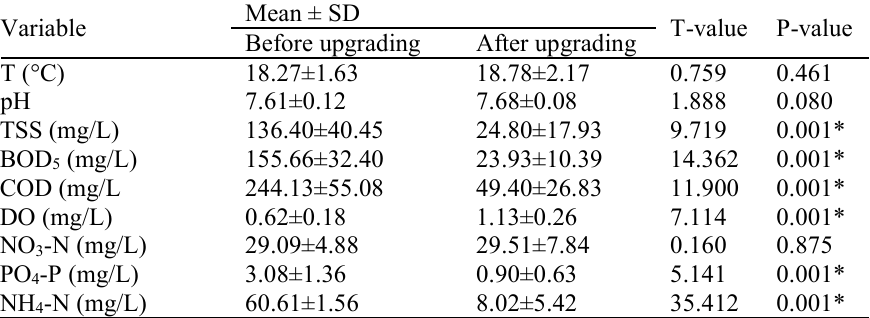
Table 6. Comparison of characteristics of Tafresh treated wastewater in each autumn season of the year 2016 (before upgrading) and 2017 (after upgrading to MLE system)